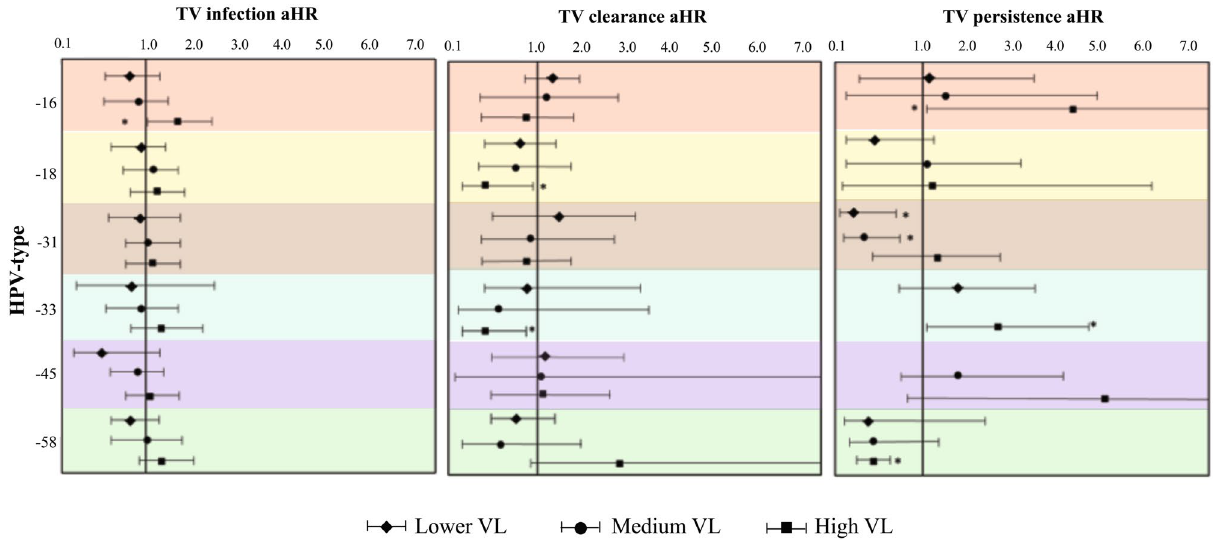
Figure 2. Risk ratios for modelling associations between TV infection, clearance and persistence and type- specific viral load. VL considered the amount of HMBS gene copies.